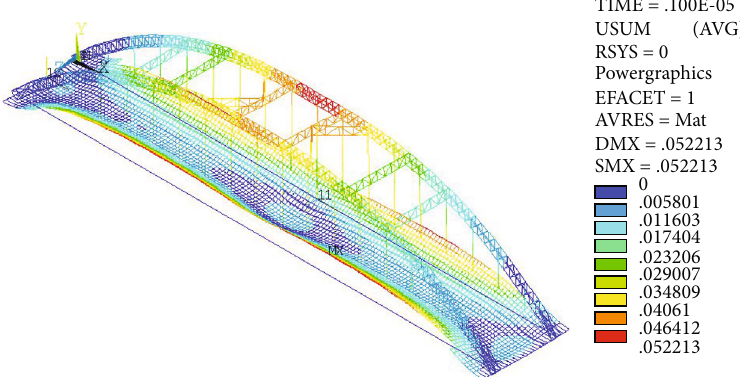
Figure 13: The overall displacement cloud map of arch bridge under case 2 (m).